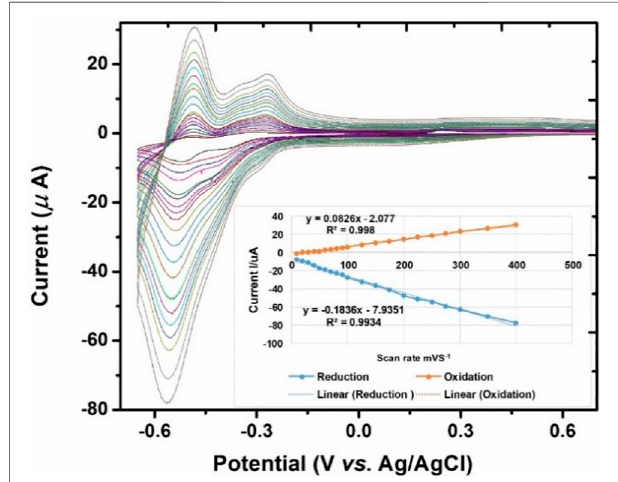
FIGURE4| CVofPDDA/P 2 W 18 POM/PEI-AgNPs/GCEin0.1 Macetate buffer at different scan rates 10 to 400 mVs -1